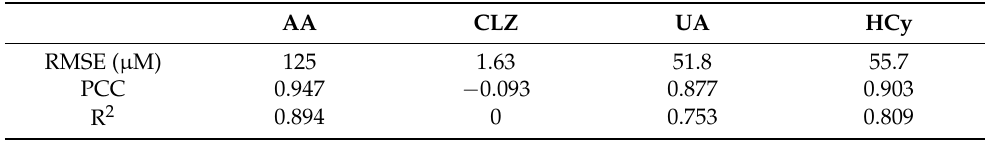
Figure 7. Diffusion- and chemometric-based multi-electrode array to quantify multiple redox-active molecules from multicomponent mixtures. Predicted vs. actual concentrations for ( A ) UA, ( B ) HCy, ( C ) AA, and ( D ) CLZ, calculated from the chemometric-based multi-electrode array. Table 2. Chemometric model prediction performance.